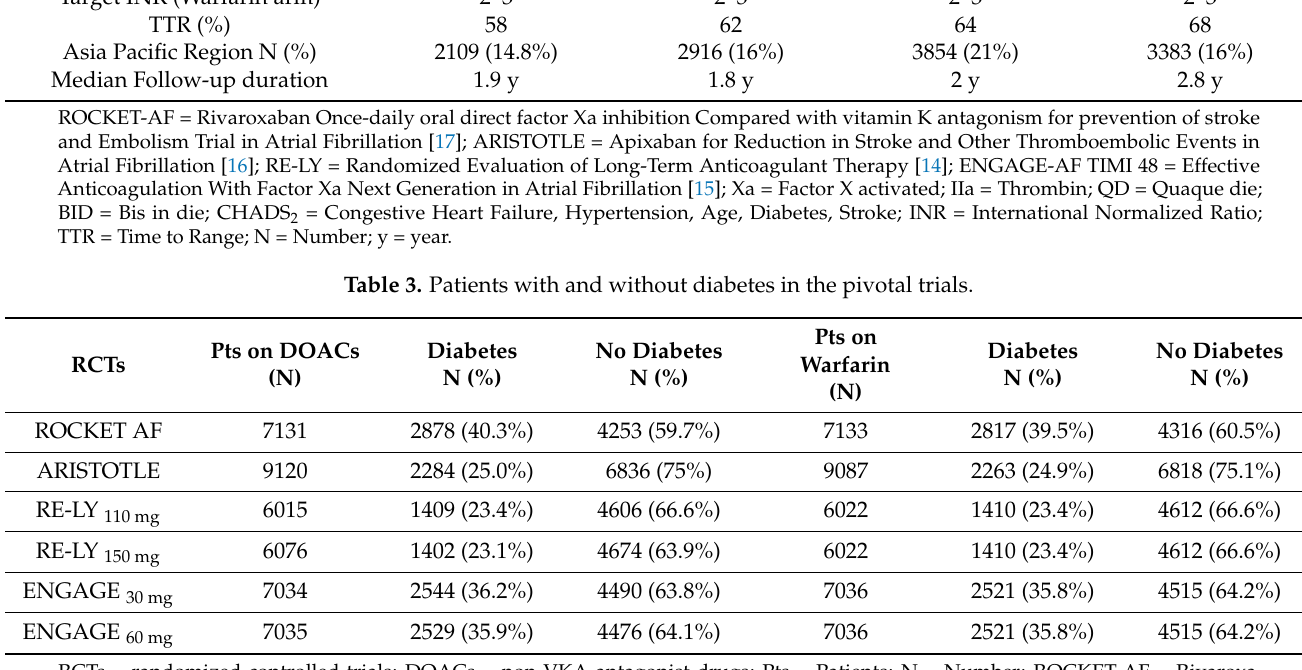
Table 4 summarized data regarding the rate of stroke/SEE, major bleeding, and